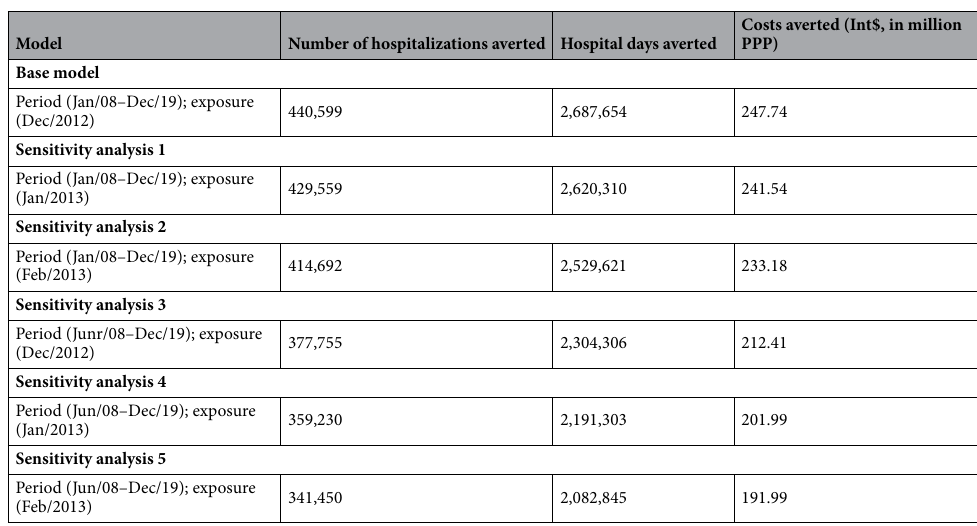
Table 6. Predicted hospitalizations, hospital days and costs averted associated with the new zero-tolerance drinking and driving law,